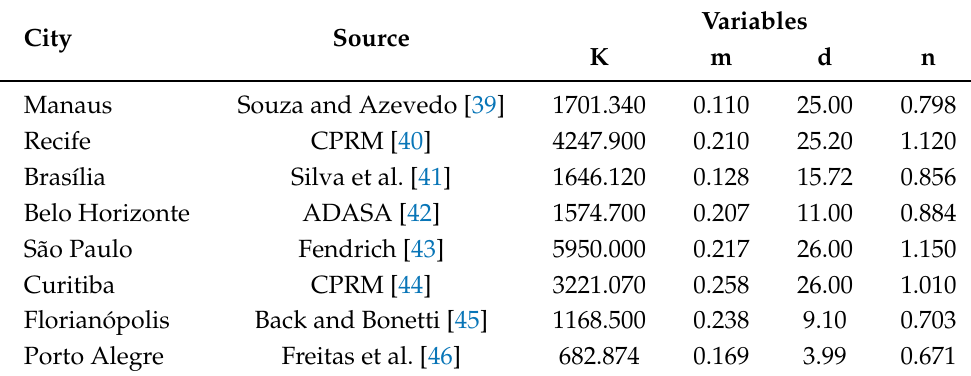
Table 3. Intensity-Duration-Frequency variables used in the hydrological design in each